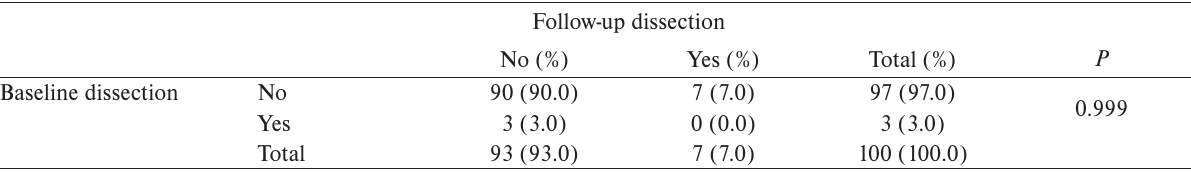
Table 3. radial artery dissection in baseline and follow-up